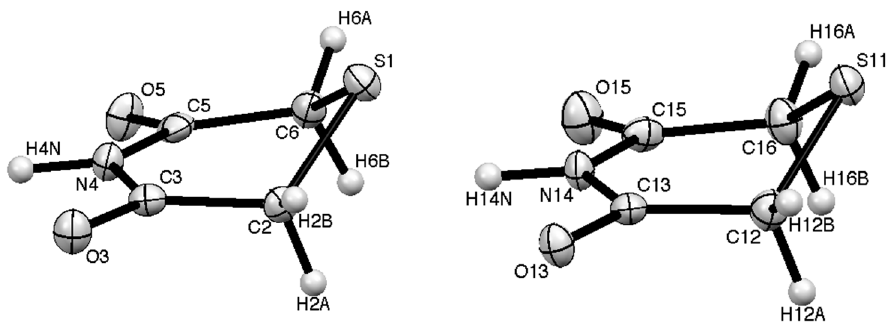
Figure 1. The two distinct molecules in the molecular structure of 1 with numbering scheme. Table 1. Selected bond lengths.